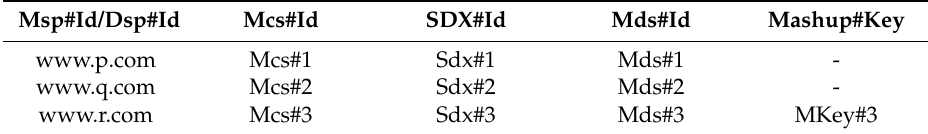
Table 4. DSC’s Mashup